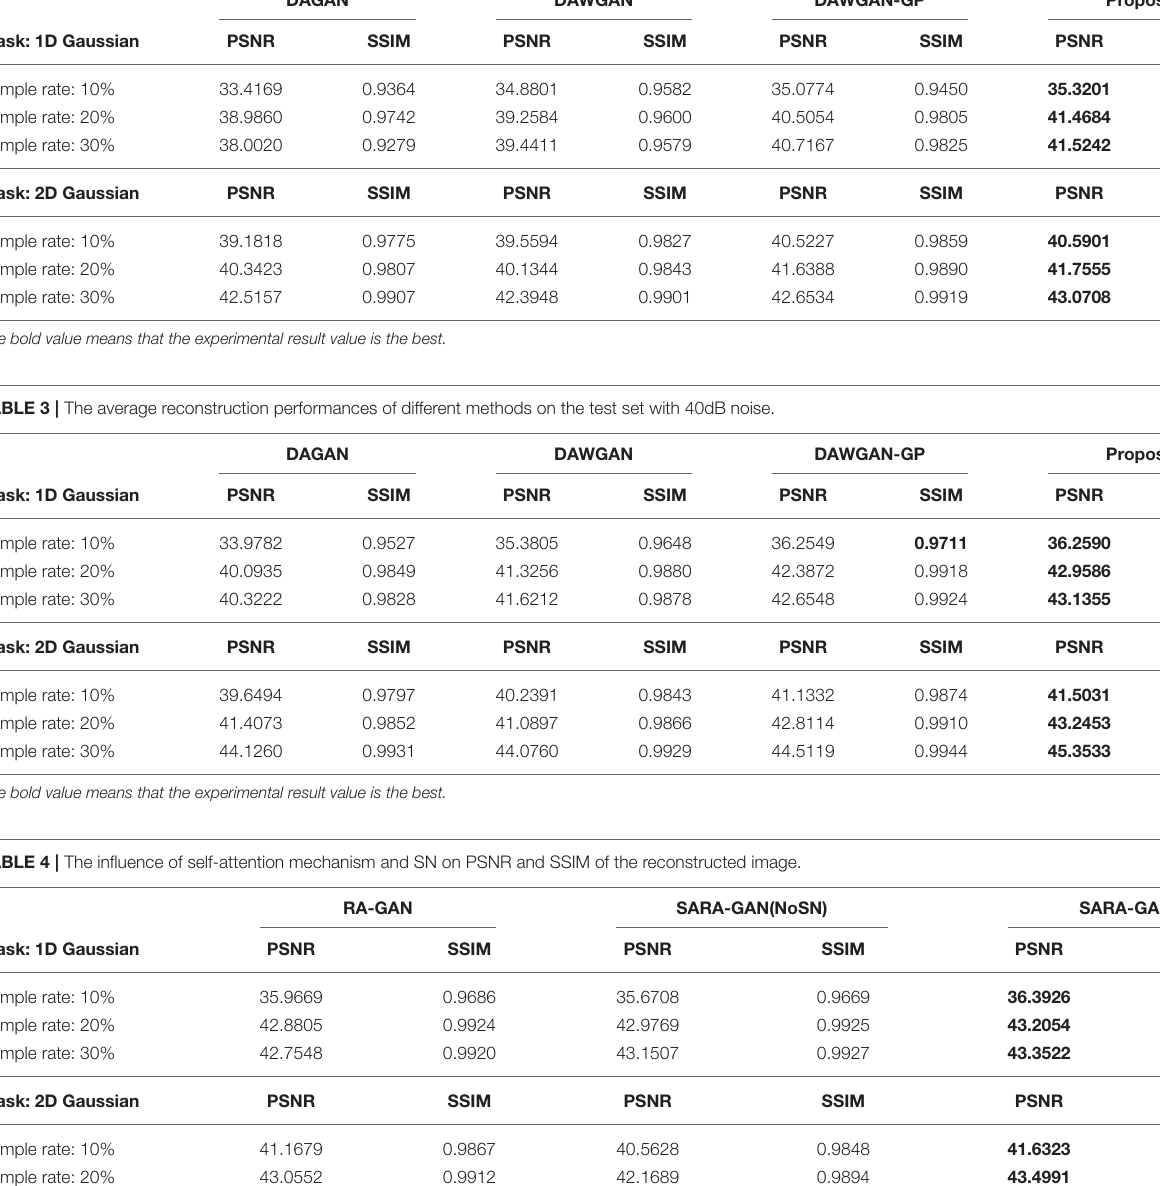
TABLE 2 | The average reconstruction performances of different methods on the test set with 30dB noise. DAGAN DAWGAN DAWGAN-GP Proposed